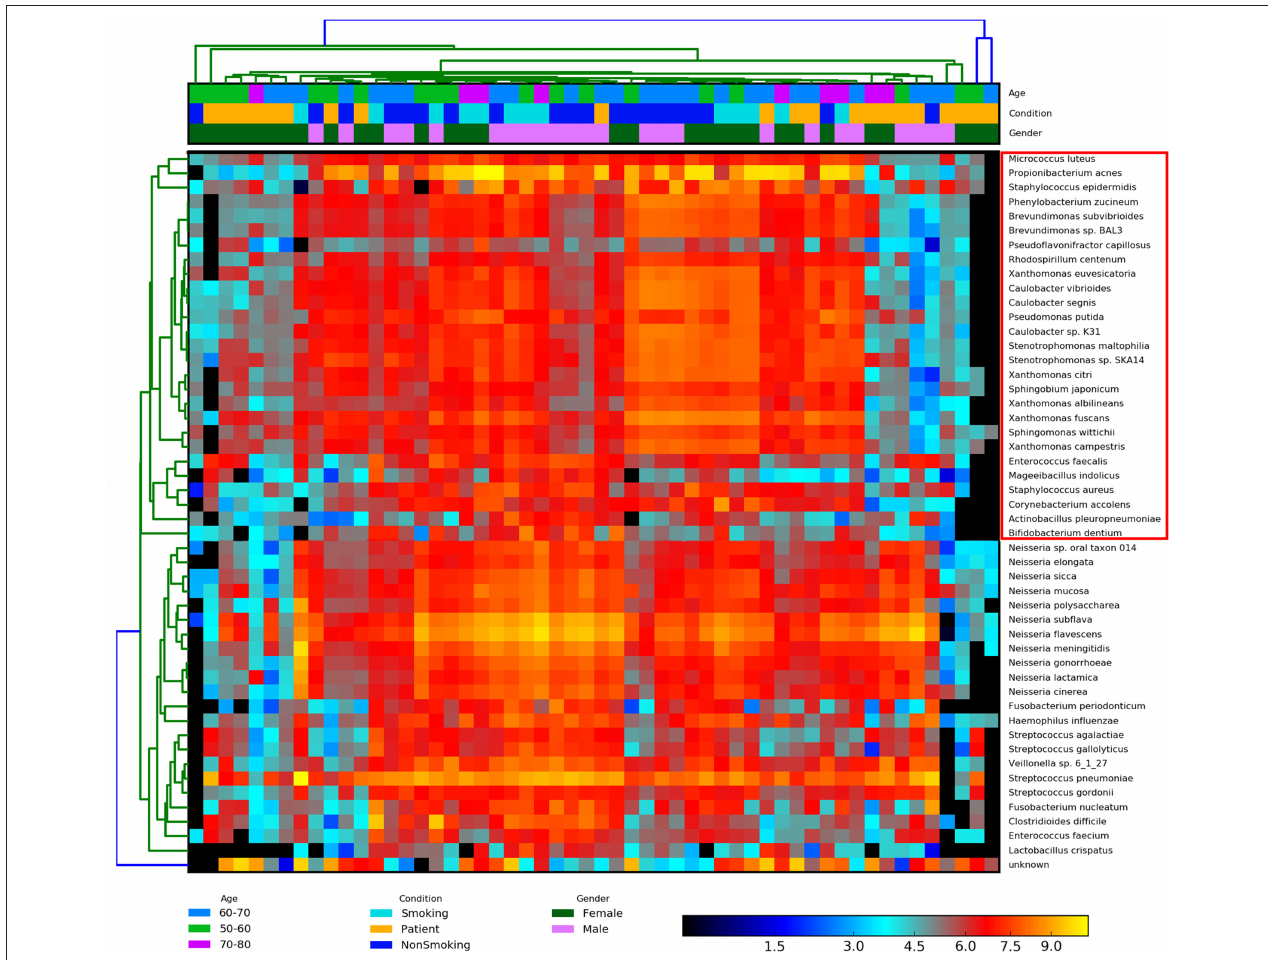
FIGURE 3 | Heatmap of the normalized abundances of all BALF samples. A similar grouping pattern on the combinations of the gender, age, and condition was also identified by Bray-Curtis matrix using the hclust2 and Mantel tests. The significant correlated of community structure of two groups was revealed ( P -value = 0.01). The species in the red box are group 1, opportunistic pathogenic bacteria primarily derived from the skin and mouth, as mentioned above. The rest species are group 2, which is mainly from gut. Heatmap is color-coded based on the normalized abundance of species, from black (lower abundance) to red (higher